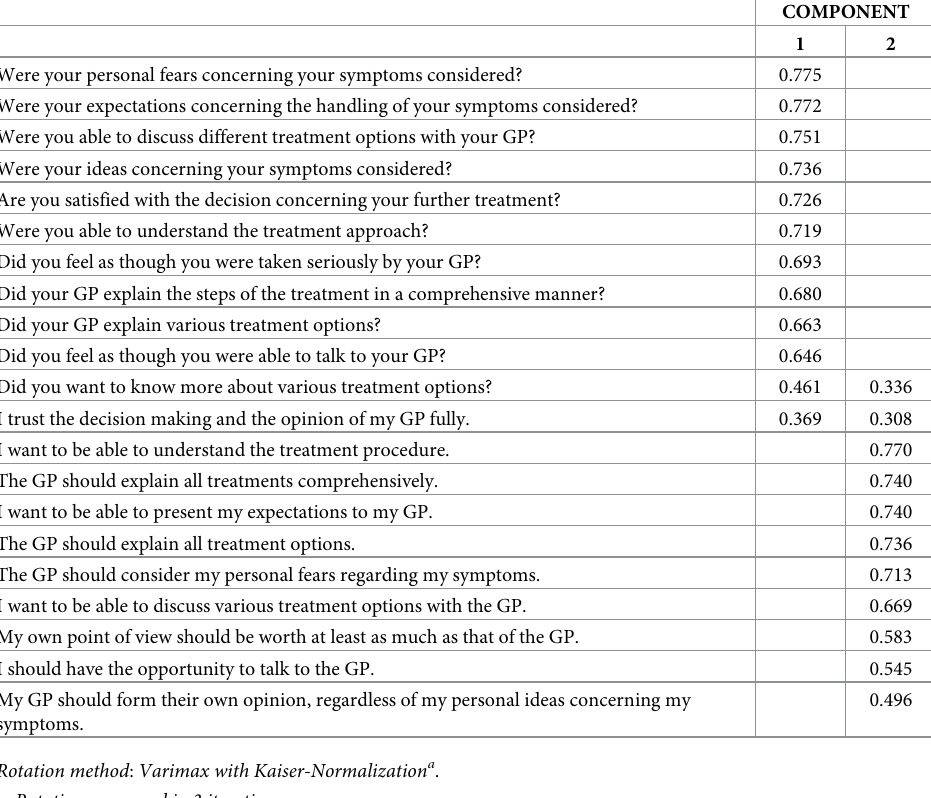
Table 2. Factor analysis: Rotated component matrix a